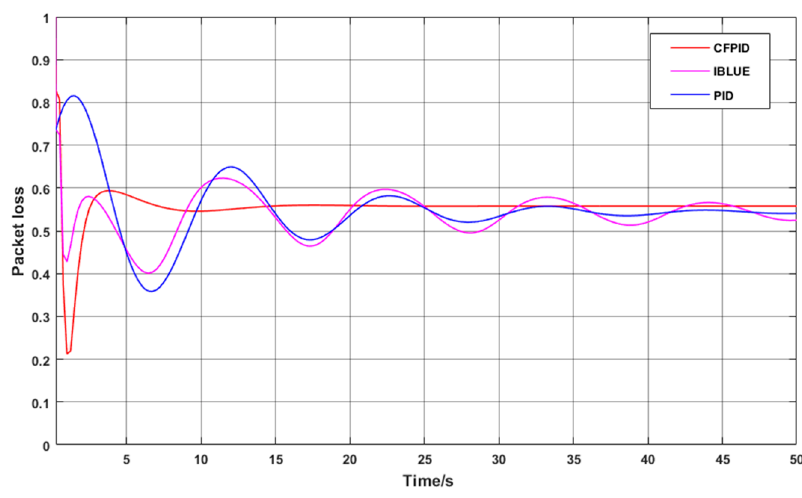
Figure 8. One-hundred node-time packet loss rate curves.